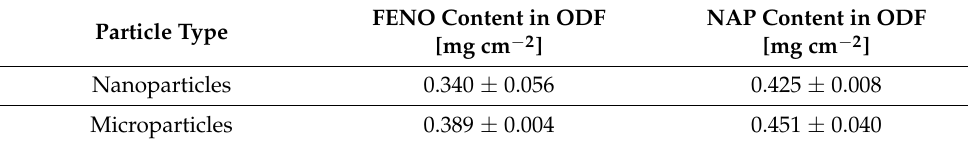
Table 3. Content of FENO and NAP in particle-containing ODFs, n =